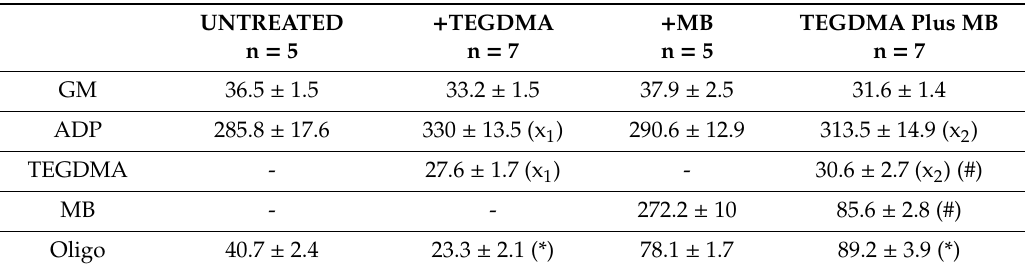
Table 1. Effects of TEGDMA on oxygen consumption of brain mitochondria supported by glutamate plus malate in the presence or absence of methylene blue.